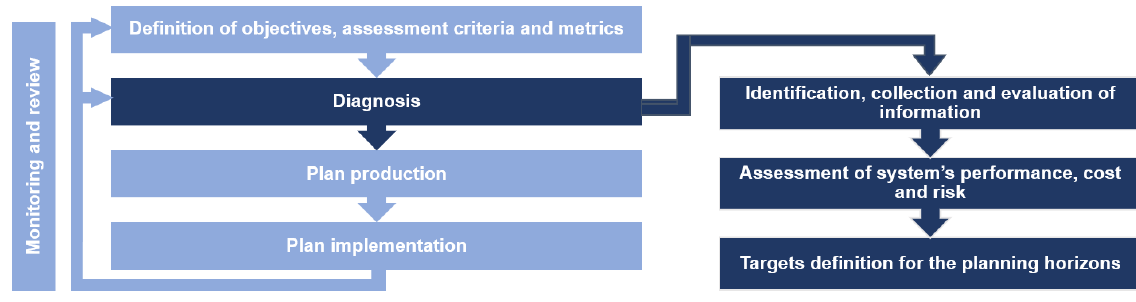
Figure 3: Stages of tactical diagnosis [4].